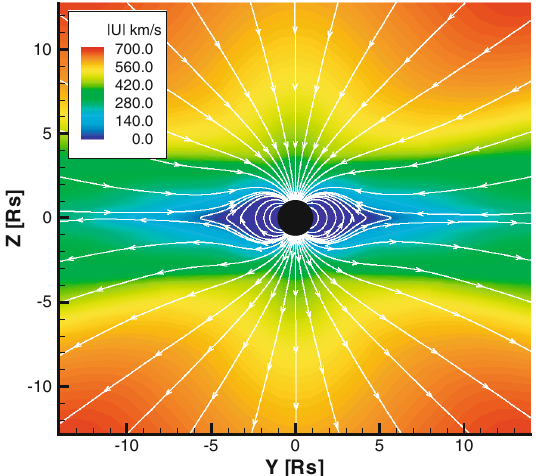
Fig. 15 Magnetic structure and velocity for the steady-state solar wind solution. Solid white lines are magnetic “streamlines” drawn in the y – z plane superimposed upon a false color image of the velocity magnitude. Note the bimodal nature of the solar wind. Image reproduced with permission from Manchester et al. (2004), copyright by